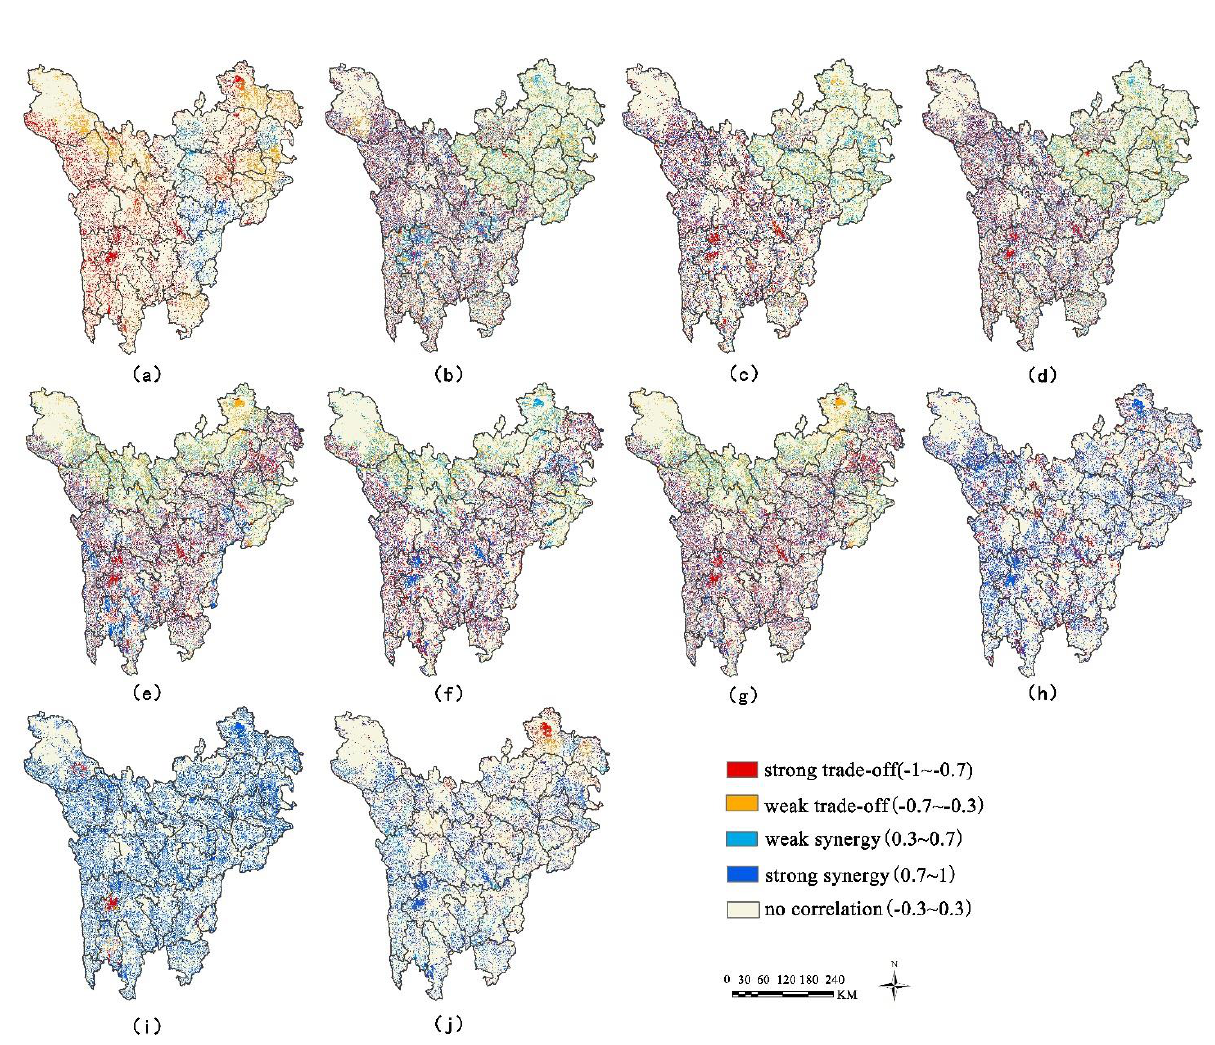
Figure 4. Spatial distribution of trade-off and synergy of ecosystem services in the western Sichuan Plateau: ( a – j ) respectively represent the trade-offs and synergies of food supply-water supply, food supply-habitat quality, food supply-soil conservation, food supply-carbon storage, water supply- habitat quality, water supply-soil conservation, water supply-carbon storage, habitat quality-soil conservation, habitat quality-carbon storage, soil conservation-carbon storage).